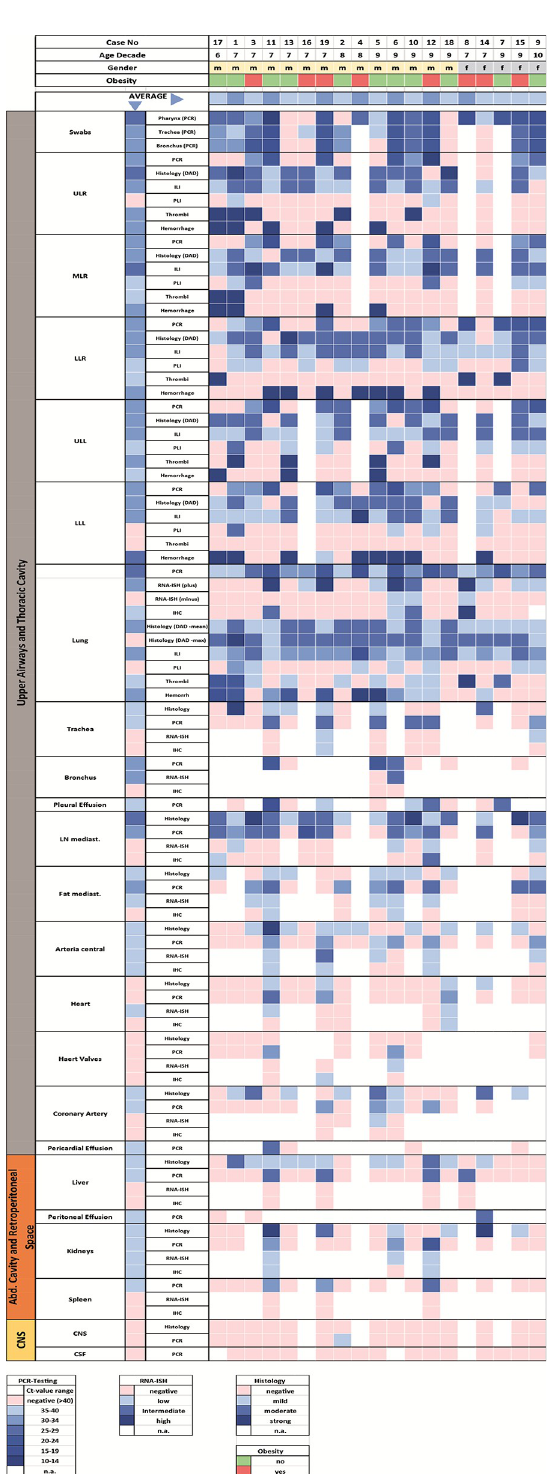
Fig 2. Organ mapping of virus positivity by different techniques. PCR = real—time quantitative polymerase chain reaction, RNA-ISH = RNA-in situ hybridization, IHC = immunohistochemistry, PLI = perivascular lymphocyte infiltration, ILI = interstitial lymphocyte infiltration, DAD = diffuse alveolar damage, ULL = upper left lobe, LLL = lower left lobe, LRL = lower right lobe, URL = upper right lobe, MRL = middle right lobe, CNS = central nervous system, CSF = cerebrospinal fluid); The category Histology represents lymphoplasmacellular inflammation of